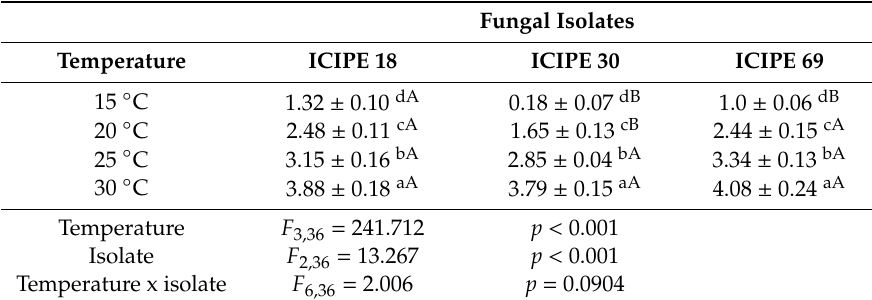
Table 2. E ff ect of temperature on the radial growth rates day − 1 of M. anisopliae